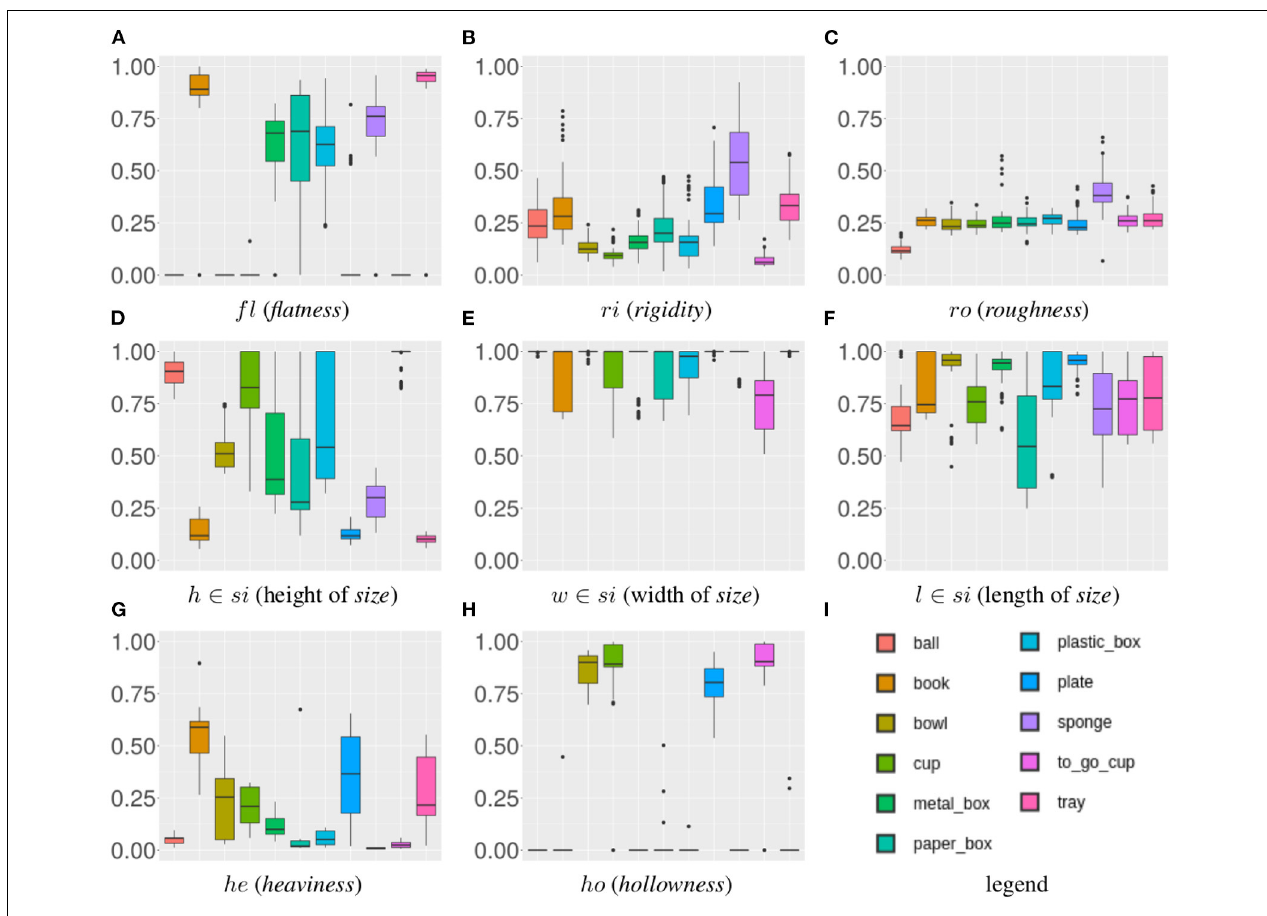
FIGURE 10 | Category-wise coverage for each physical property [ fl , ri , ro , si , he , ho ].